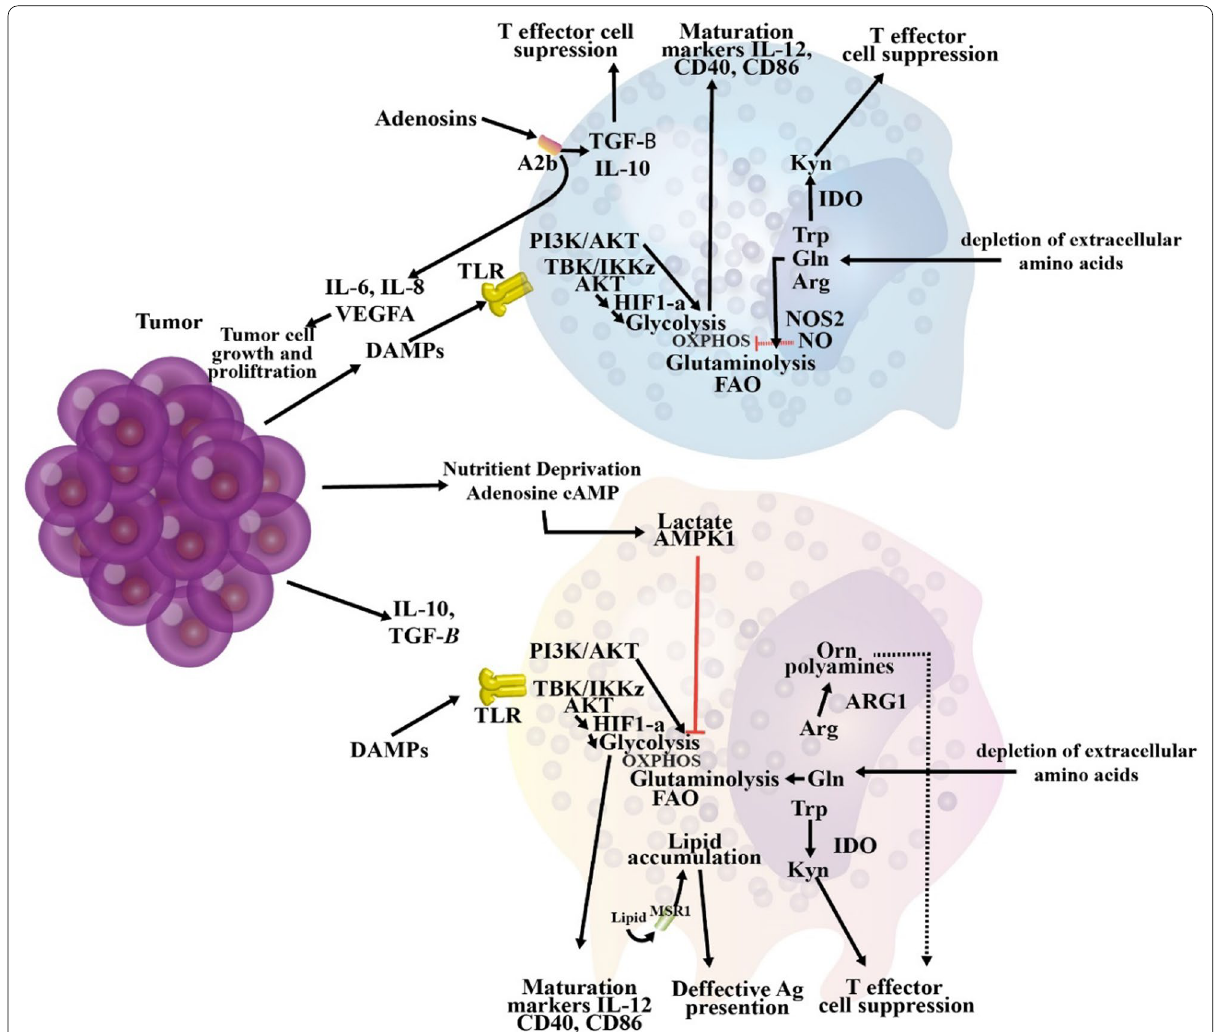
Fig. 5 Metabolic alterations in tumor-associated dendritic cells (TADCs) during tumor progression. TADCs encounter hypoxia and tumor-derived damage-associated molecular patterns (DAMPs) to upregulate glycolysis via an initial TBK1-IKKε pathway and/or later PI3K-AKT-HIF1α pathway. HIF1α impairs the maturation of DC cells and upregulates the expression of A2b and NO (which inhibits OXPHOS). A2b-adenosine interaction induces immunosuppressive cytokines (e.g., TGF-b and IL-10) and pro-tumor cytokines (e.g., IL-6 and IL-8) that promote tumor growth. Nutrient deprivation-induced AMPK activation and lactate accumulation suppress glycolysis and upregulate OXPHOSP in TADCs. In addition, amino acid uptake, metabolism, and lipid accumulation promote immunosuppressive events that lead to tumor growth